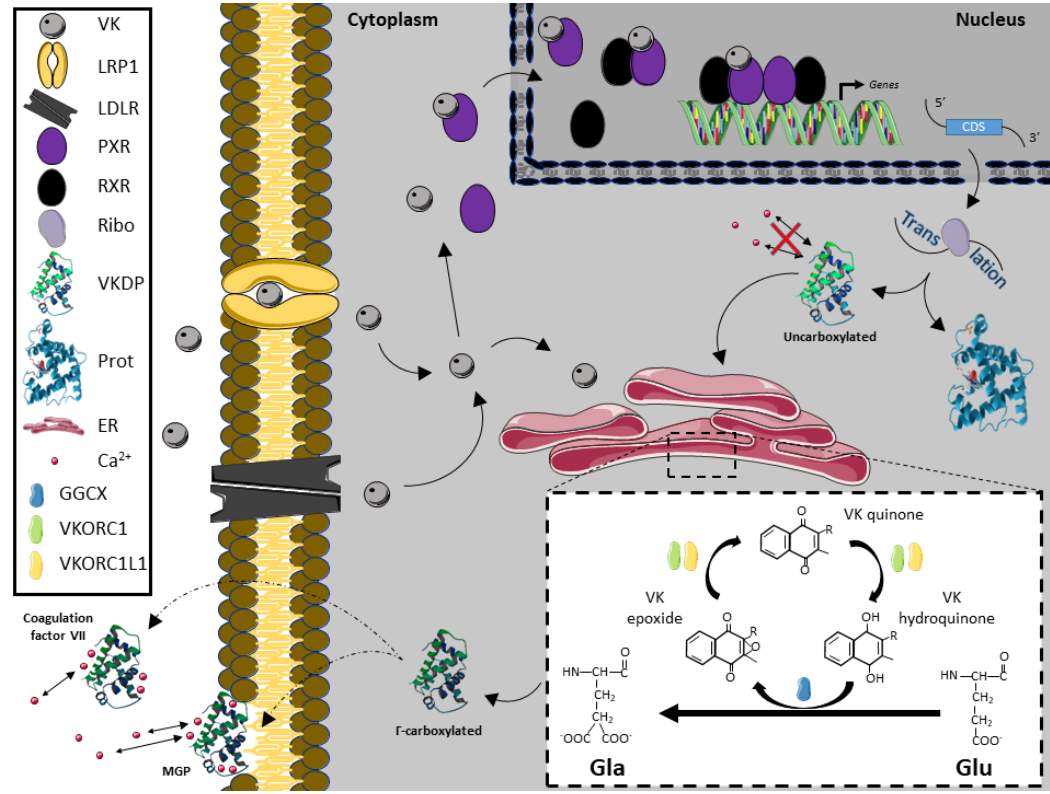
Figure 2. Vitamin K metabolic and transcriptional roles . Vitamin K (VK) enters cell cytoplasm through the action of low-density lipoprotein receptor (LDLR) and prolow-density lipoprotein receptor-related protein 1 (LRP1). VK might transactivate pregnane X receptor (PXR), which in turn form an heterotetramer with the retinoid X receptor (RXR) able to be bound to the DNA RXR-PXR response element sequences and recruit co-activators and RNA polymerase II in order to transcribe the target genes. In this manner, PXR is able to activate the transcription of different genes, including known VK dependent proteins (VKDPs), as such MGP, among others. After genes encoding VKDPs are transcribed, mRNAs are translated to the corresponding proteins. VKDPs can undergo γ -carboxylation at the endoplasmic reticulum (ER), where VK (quinone form) is reduced to VK hydroquinone which acts as a co-factor of the γ -glutamyl carboxylase (GGCX) enzyme to γ -carboxylate those VKDPs. As a result of the conversion of Glu residues in Gla residues, VKDPs are able to bind calcium ions (Ca 2 + ) while VK hydroquinone is oxidated to VK epoxide. Both VK epoxide reductase complex subunint 1 (VKORC1) and VKORC1-like protein 1 (VKORC1L1) enzymes are able to reduce VK epoxide to VK quinone and VK quinone to VK hydroquinone; therefore recycling VK. CDS , coding sequence; ER , endoplasmic reticulum; GGCX , γ -glutamyl carboxylase; Gla , γ -carboxylated glutamic acid; Glu , glutamic acid; LDLR , low-density lipoprotein receptor; LRP1 , low-density lipoprotein receptor-related protein 1; MGP , matrix Gla protein; Prot , protein; PXR , pregnane X receptor; Ribo , ribosomal subunits; RXR , retinoid X receptor; VK , vitamin K; VKDP , VK dependent protein; VKORC1 , VK epoxide reductase complex subunit 1; VKORC1L1 , VKORC1-like protein